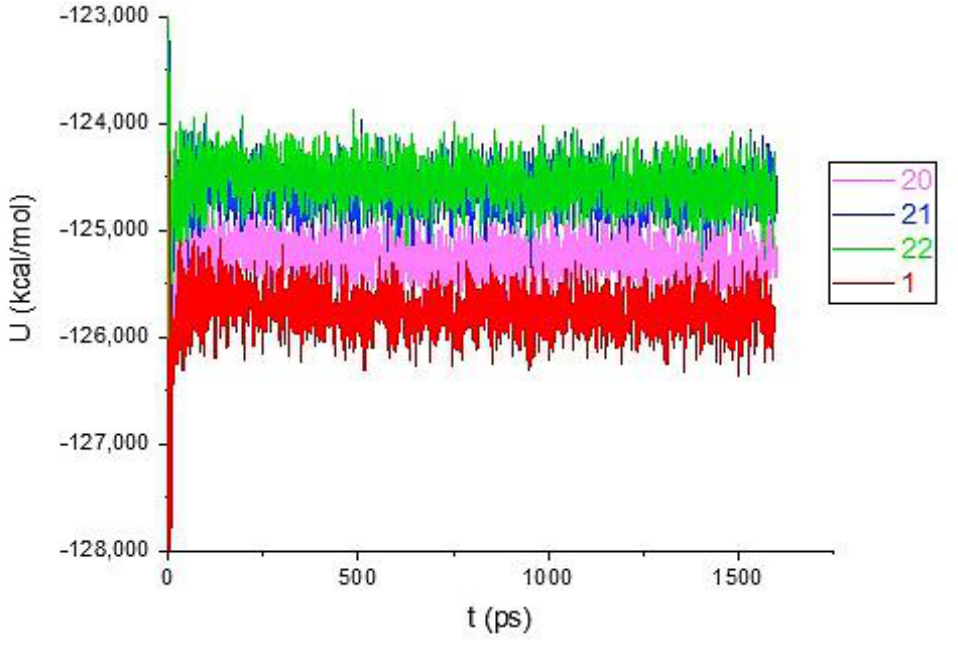
Figure 2. The evaluation of potential energy of complexes of 1 and 20 − 22 with 2OM3 receptor as a function of time.